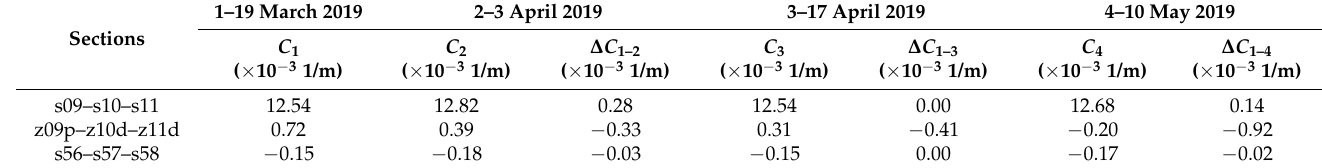
Table 4. The values of curvatures and their changes observed on two neighboring sections in the time Sections period of March–May 2019.